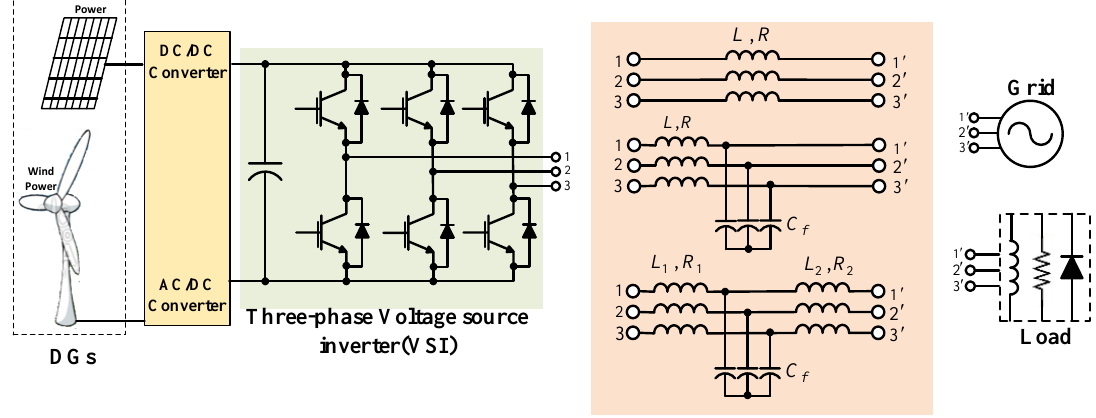
Figure 1. Three-phase voltage source inverter (VSI) connected to grid/load through inductive (L)/inductive-capacitive (LC)/inductive-capacitive-inductive (LCL) filters. DG: distributed generation.